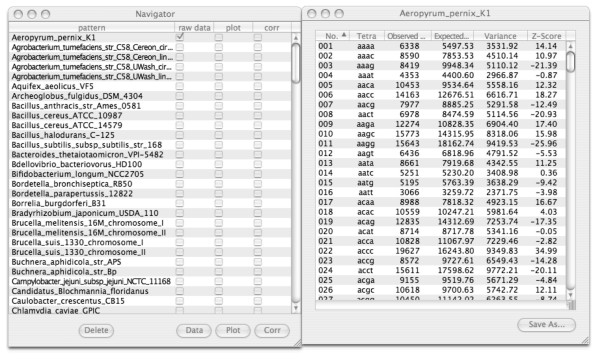
(left) Navigator window of the TETRA stand-alone program showing a subset of the pre-computed 166 prokaryote chromosomes for selection. (right) Data window with a subset of the tetranucleotide frequencies of the Aeropyrum pernix K1 chromosome.